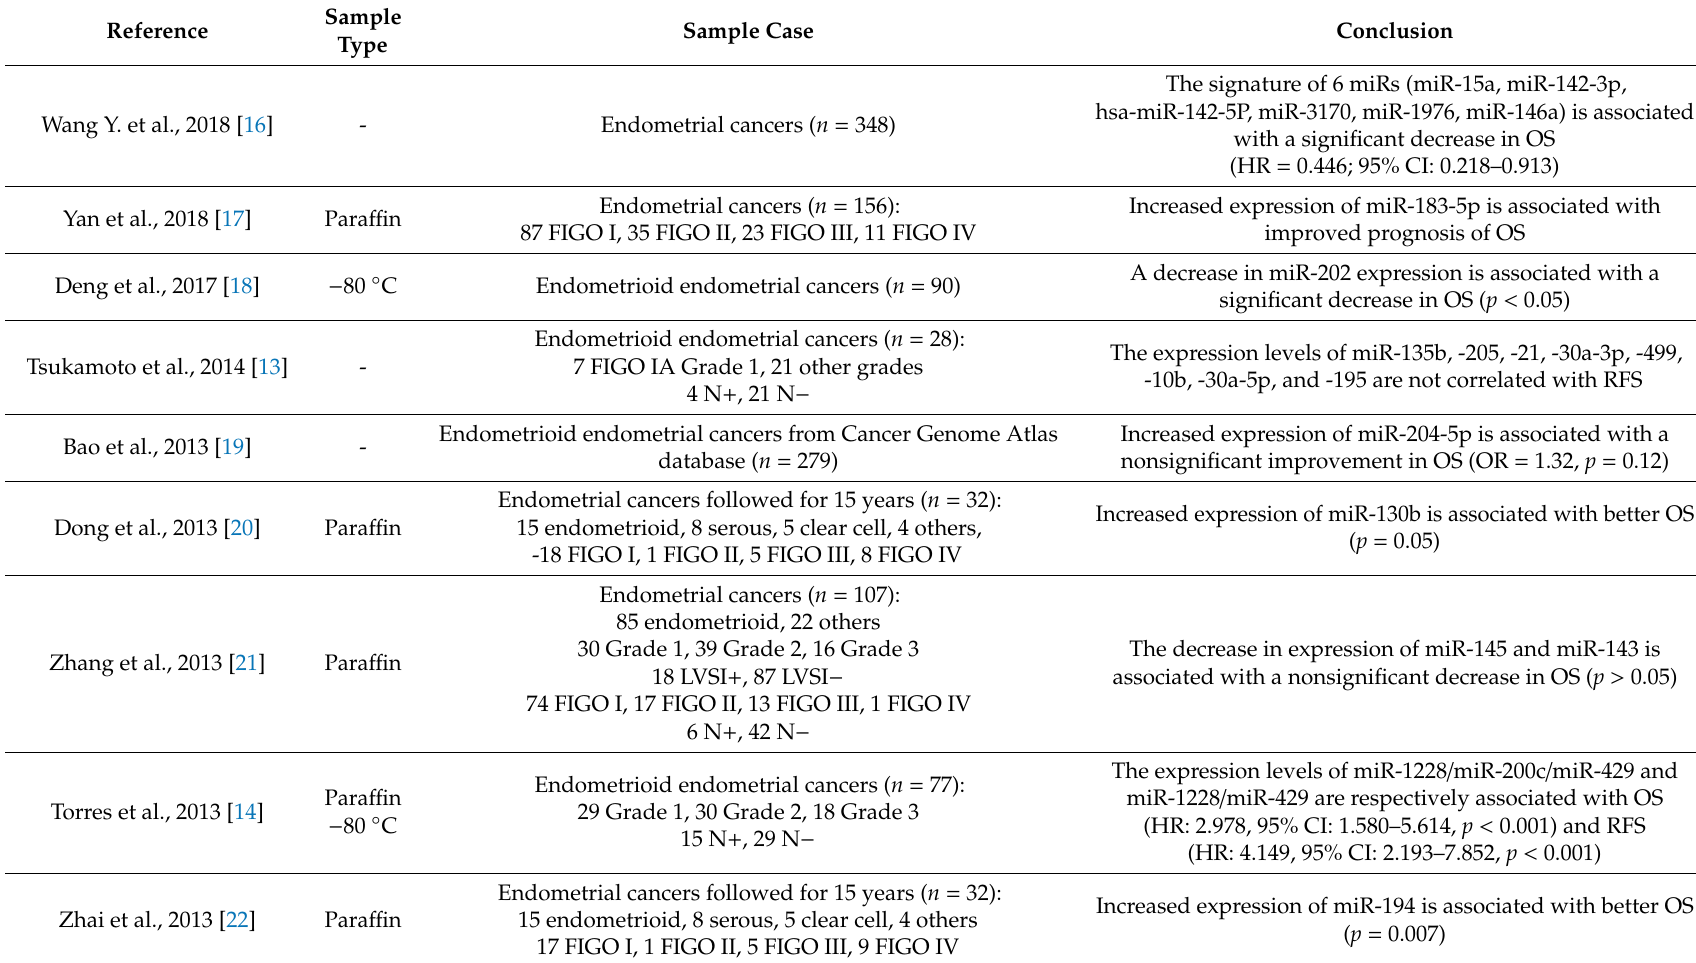
Table 2. Expression profile of microRNAs within neoplastic endometrial tissue according to